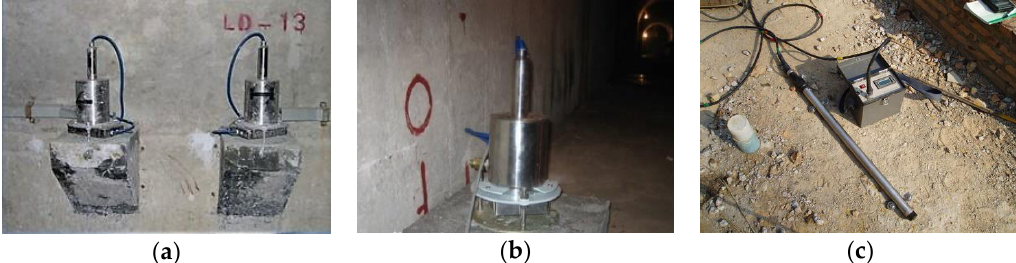
Figure 1. Various types of devices to measure the different physical quantities ( a ) static level; ( b ) inverted vertical meter; ( c ) seam measurement meter.